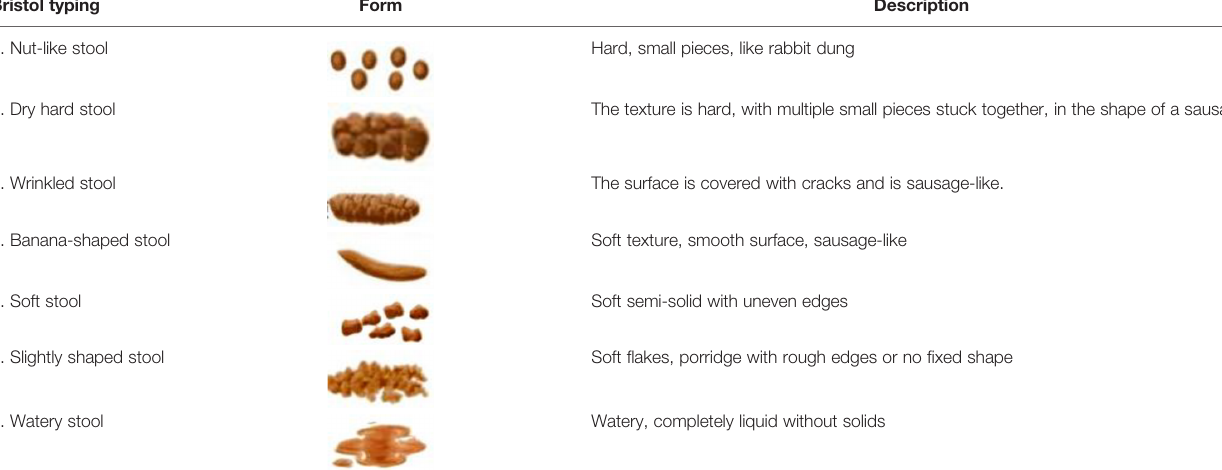
TABLE 1 | Bristol stool